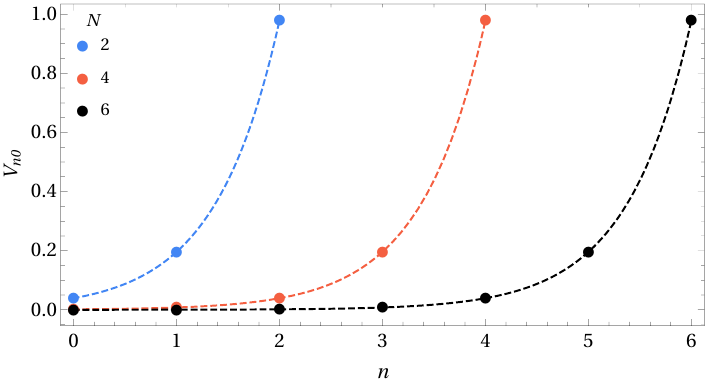
Figure 5 . Zero mode pro(cid:12)les for chains of lengths N = 2 (blue), N = 4 (red), and N = 6 (black), setting q = 5. The overlaps with the zero node, n = 0, are exponentially